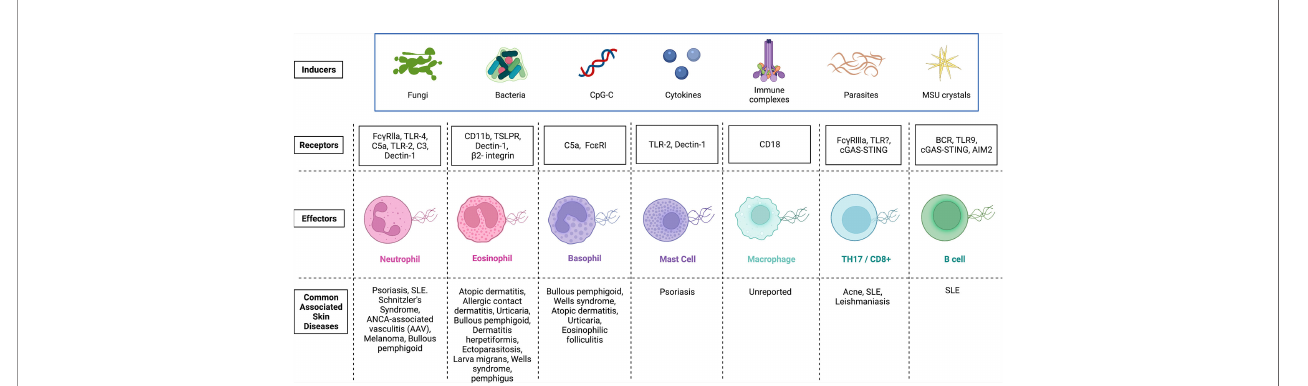
FIGURE 2 | Inducers and potential receptors that activate the release of extracellular traps in immune cells and the associated skin diseases. Extracellular traps were fi rst identi fi ed in neutrophils, and later, this phenomenon was detected in several other immune cells. Although there exists some overlap, inducers and receptors vary widely. Activation of immune cells by microbes, CpG-C, cytokines, immune complexes, parasites and MSU crystals can initiate the release of extracellular traps. Receptors on immune cells (Effectors) that have been identi fi ed and demonstrated to interact with inducers of extracellular trap formation are shown. Mechanisms by which ET formation are initiated in various effector cells vary and any dysregulation of each cascade can be pathological. Skin diseases associated with dysregulated extracellular trap formation are highlighted. Fc g Rs, Receptors for the constant region of IgG immunoglobulin; TLR, Toll-like receptor; C5a, Complement component 5a; C3, Complement component 3; TSLPR, Thymic stromal lymphopoietin receptor; Fc ϵ RI, High af fi nity IgE; BCR, B cell receptor; STING, Stimulator of interferon genes; MSU, Monosodium urate; CpG-C, Synthetic short single-stranded DNA molecules made of cytosine triphosphate deoxynucleotide. Created with